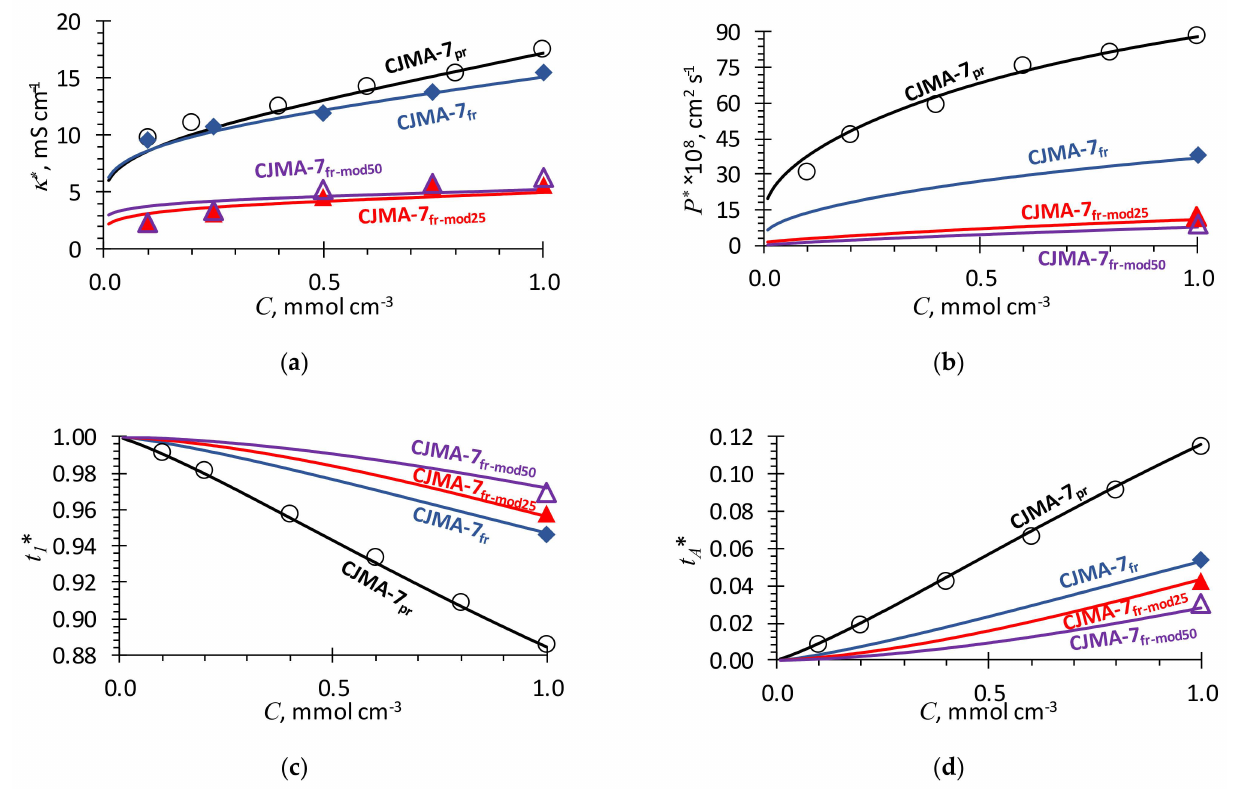
Figure 1. Experimental and simulated using the MH model concentration dependencies of ( a ) con- ductivity, ( b ) diffusion permeability, ( c ) counterion and ( d ) coion transport numbers for studied membrane samples (indicated near the corresponding curve). Markers denote the experimental data, lines denote the results of the